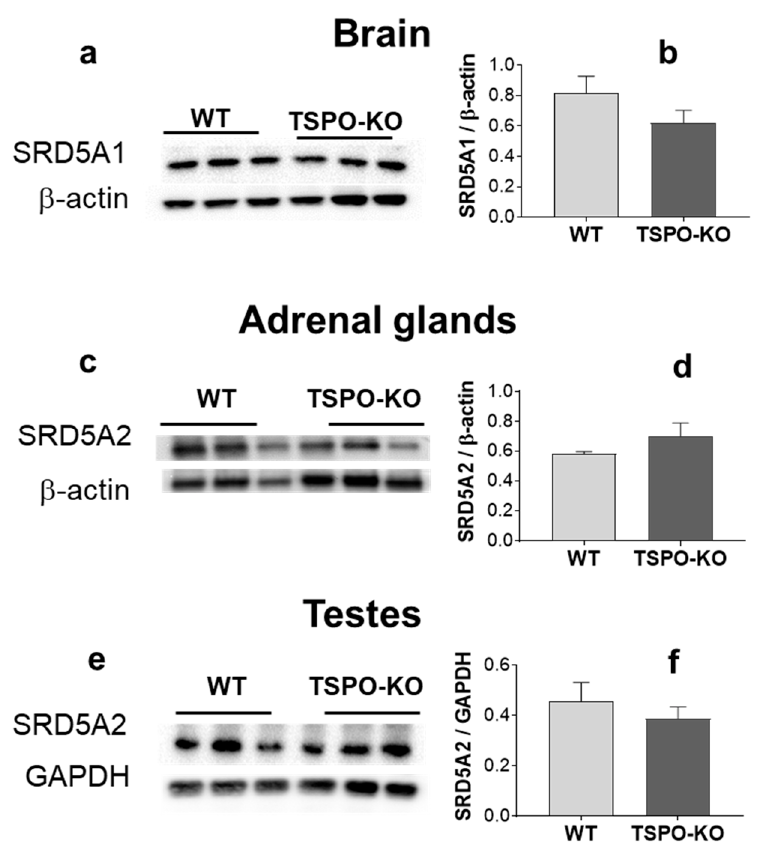
Figure 10. Western blot analysis of SRD5A protein levels in the brain, adrenal glands and testes from TSPO-KO and WT mice. Representative bands of SRD5A1, SRD5A2 and the loading controls β -actin or GAPDH for all tissues are shown ( a , c , e ). Quantification of SRD5A levels was normalized to the loading control ( b , d , f ).